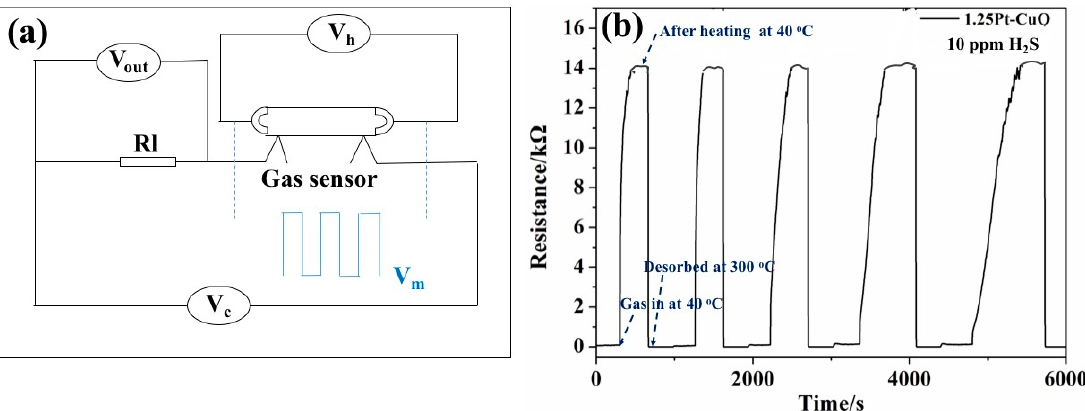
Figure 9. ( a ) Sensing diagram of the gas sensor with a 4.6 V electric modulation voltage; ( b ) the recovery cycles for 10 ppm H 2 S of the 1.25Pt-CuO sensor at 40 °C, followed by a 4.6 V electric modulation voltage.